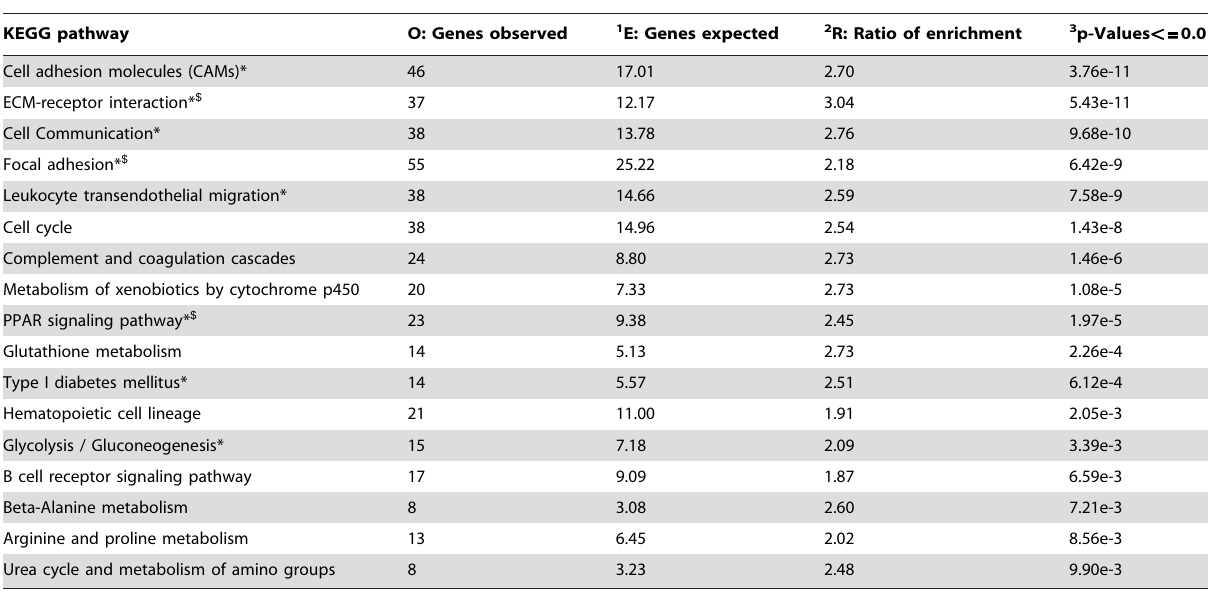
Table 5. Significantly enriched KEGG pathways for switch-like genes ( p , =0.01).